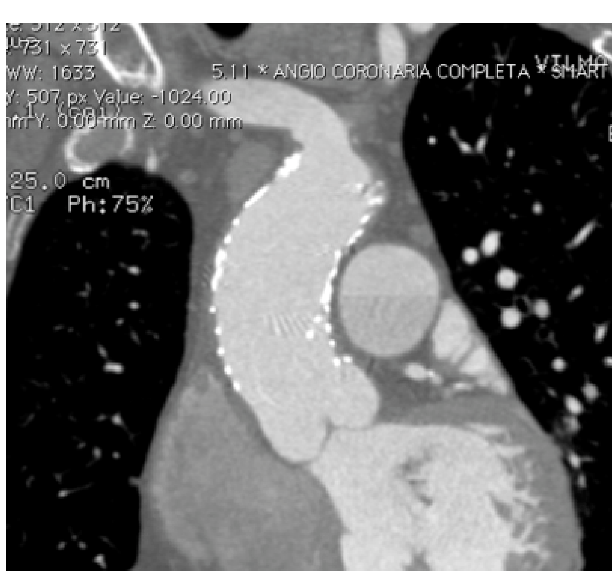
Fig. 1 – Computed tomography post stent graft in ascending aorta.